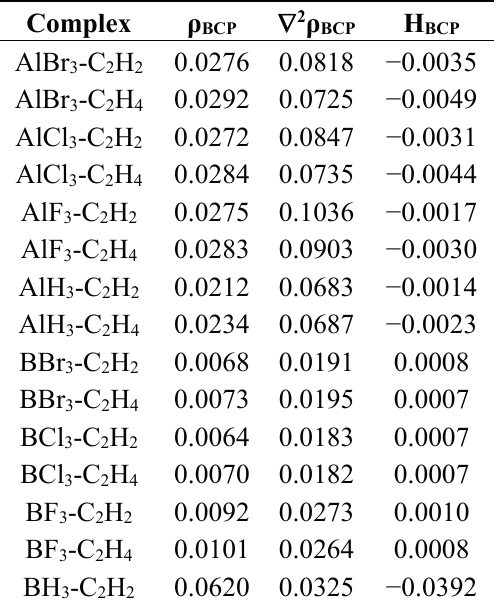
Table 2. The characteristics of the bond critical point (in au) corresponding to the bond path linking the Z-center with the π -electron system; the electron density at BCP, ρ BCP , its laplacian,  2 ρ BCP , and the total electron energy density at BCP, H BCP